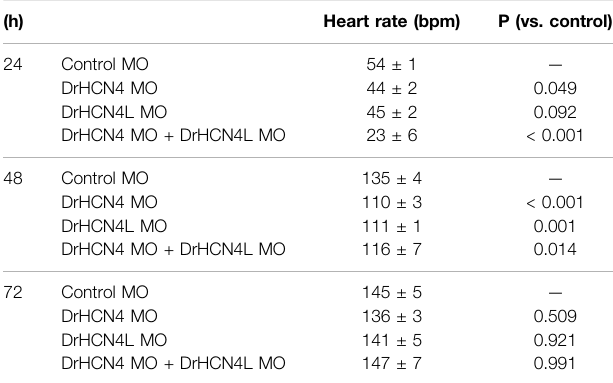
TABLE 6 | Inhibitory effects of antisense MO on heart rates (bpm) and p -values in developing zebra fi sh embryos. (h) Heart rate (bpm) P (vs.